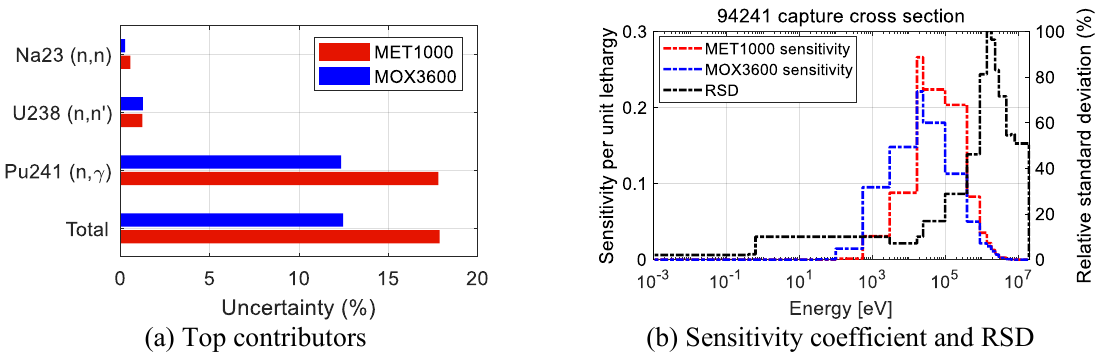
Figure 4. Uncertainty contributions to 𝛔